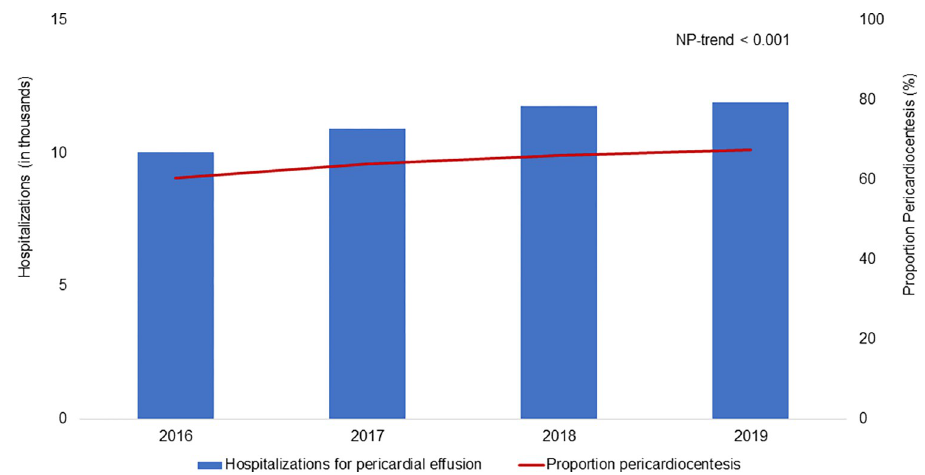
Fig 1. Trends of hospitalizations for pericardial effusion and pericardiocentesis utilization over study period. Abbreviations: NP-trend , Cusick’s non-parametric test for trend.